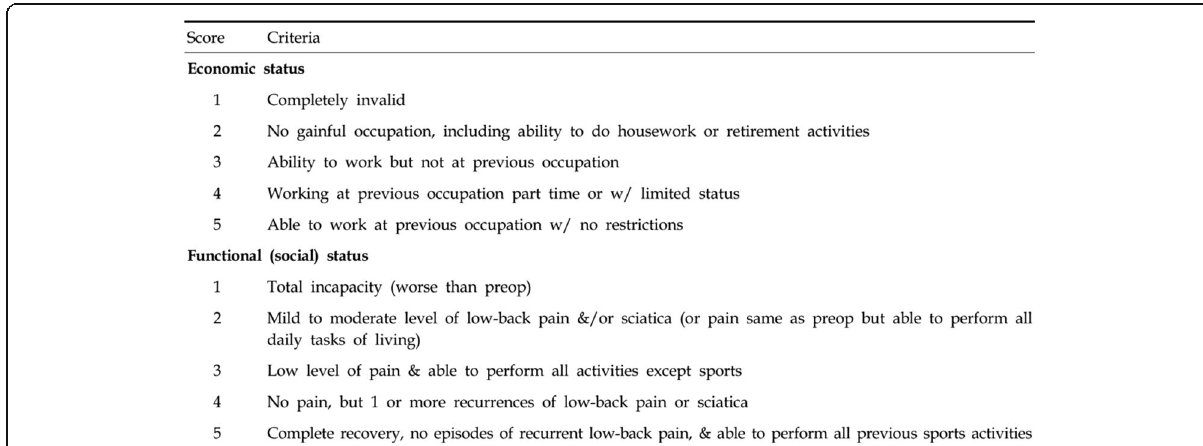
Fig. 12 Prolo economic and functional rating